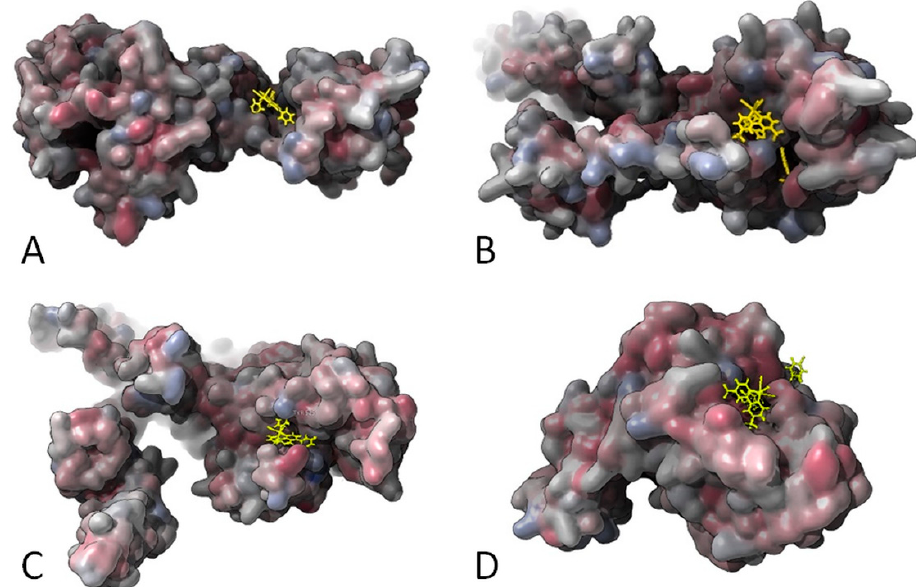
Figure 7. Gaussian surface representation of the hydrophobicity of ( A ) 15 and PBP2 (2OLV); ( B ) 19 and PBP2a (4DKI); ( C ) 15 and PBP3 (3VSL); and ( D ) 19 and PBP4 (5TXI). The red-blue color palette changes from hydrophilic blue to hydrophobic red.